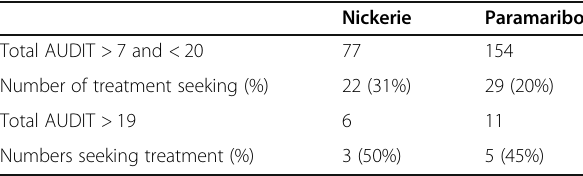
Table 5 Treatment (mental and physical) seeking for